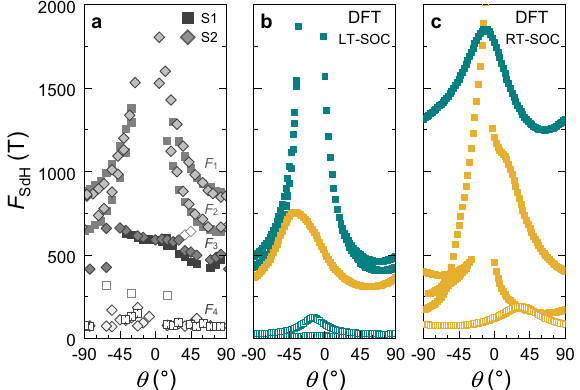
Fig. 3 Angular dependence of the observed and calculated quantum oscillation frequencies. a F SdH ( θ ) measured in two samples, S1 and S2, cut from different crystals of the same growth batch. Four distinct branches can be identi fi ed, labelled as F 1 to F 4 . b, c F SdH ( θ ) expected from the LT and RT Fermi surface models as shown in Fig. 2, with the electron and hole-pockets colour-coded accordingly. Note that the y -axis for all panels is the